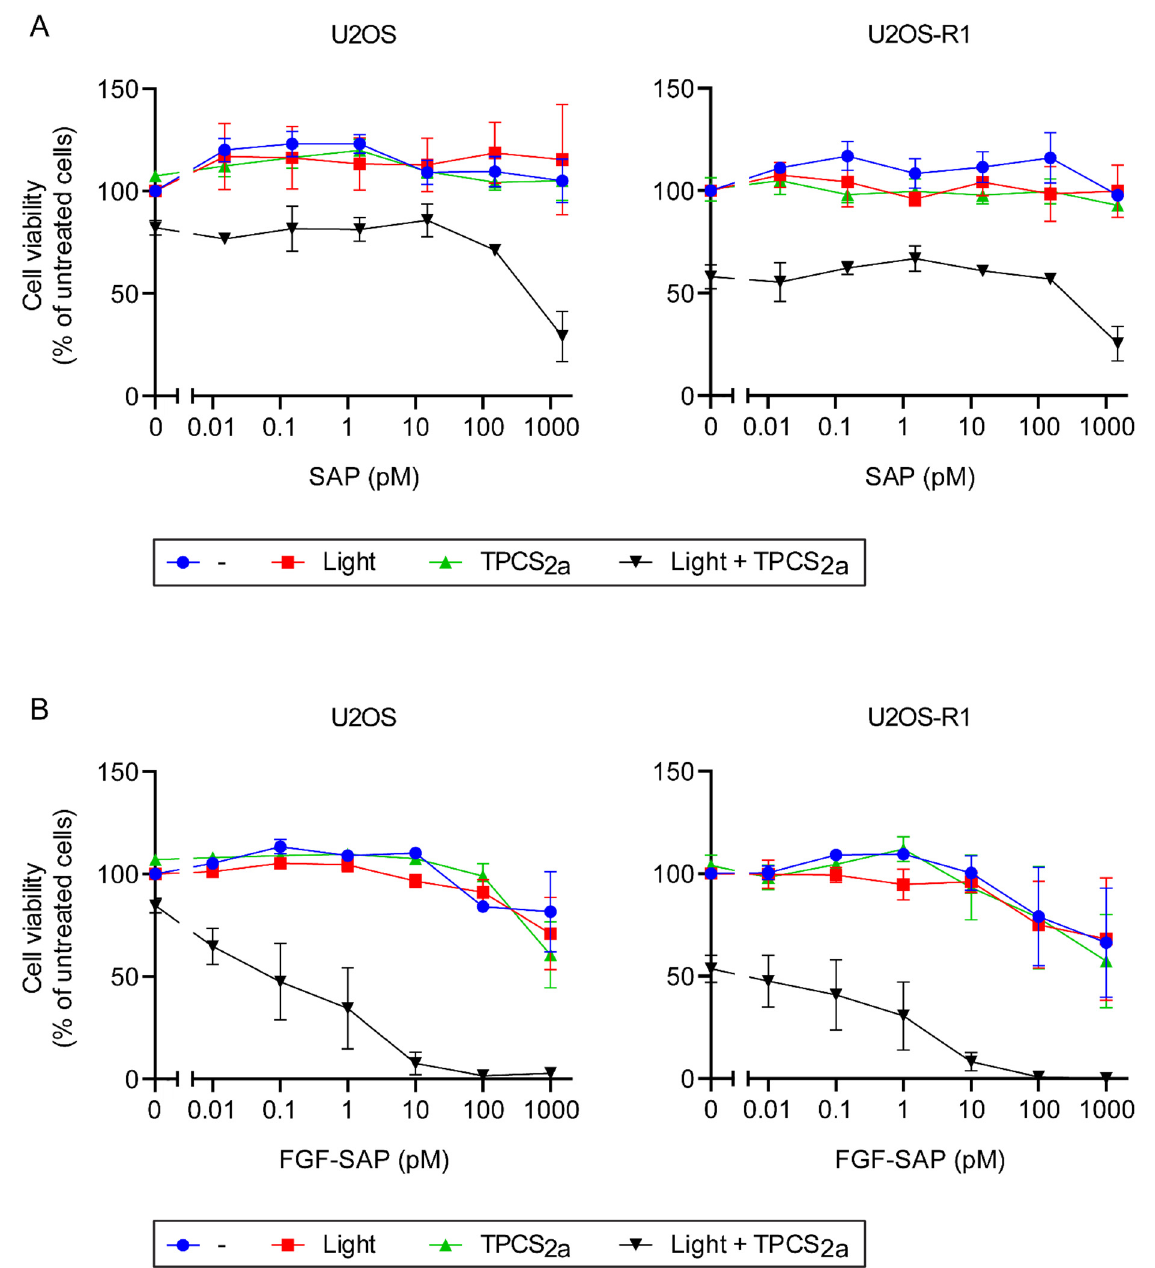
Figure 3. Cytotoxic effects of SAP ( A ) and FGF-SAP ( B ) with or without PCI in U2OS and U2OS-R1 cells. Cells were incubated with increasing concentrations of SAP or FGF-SAP for 18 h in the presence or absence of 0.2 µ g/mL TPCS 2a , washed and incubated further for four hours in drug- and TPCS 2a -free medium. The cells were then exposed or not to blue light for 120 s and MTS were assessed 48 h later. The following conditions were tested: drug (SAP/FGF-SAP) alone (blue), drug and light exposure (red), drug and TPCS 2a (green), drug, TPCS 2a and light exposure (black). The data are presented as means relative to the mean of untreated cells (in the case of TPCS 2a treatment, cells without TPCS 2a were included for each sample and used for normalization). The graph represents the mean of three independent experiments with three replicate samples for each condition in each experiment. Error bars ± SEM, n =